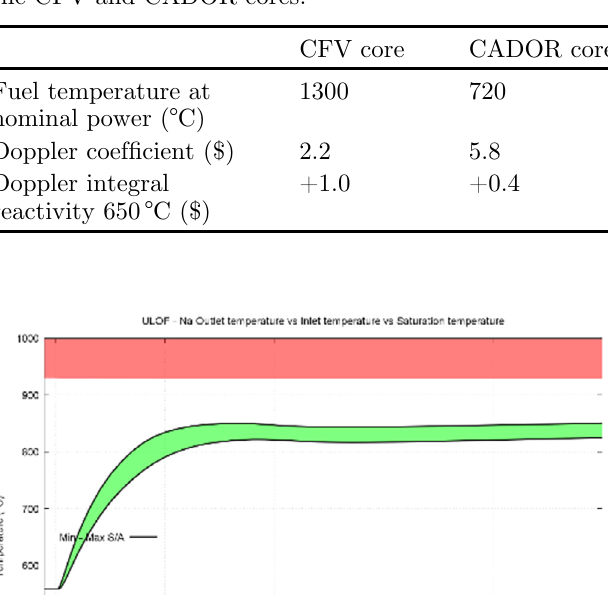
Table 3. Doppler reactivity effect in a LOHS accident for the CFV and CADOR cores.